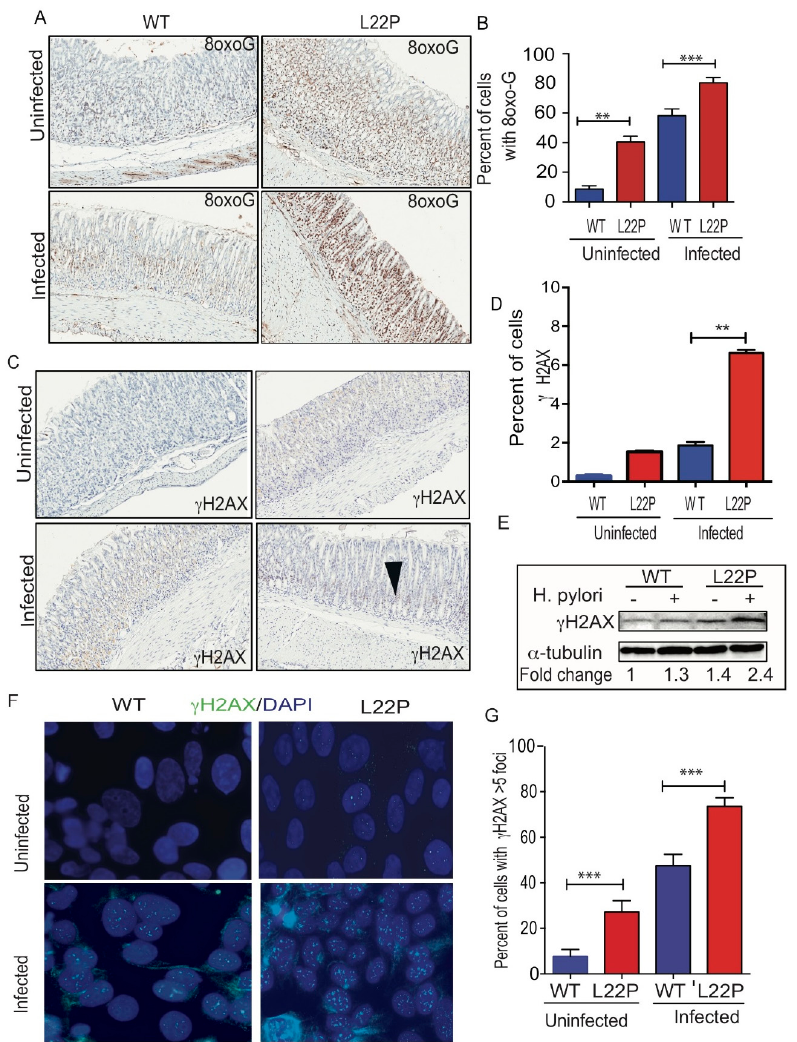
Figure2. Mutationin POLB exacerbates H.pylori inducedgenomicinstabilityinmice. ( A )Representative staining of 8oxoG on WT and L22P cells with and without H. pylori infection; ( B ) Estimated percent of cells positive for 8oxoG lesions on WT and L22P with and without infection; ( C ) Immunohistochemistry staining of γ H2Ax in WT and L22P infected with H. pylori ; ( D ) Estimated percent of positive cells for γ H2AX in WT and L22P infected and non-infected groups; ( E ) Western blot for γ H2AX on WT and L22P mice, with and without infection; ( F ) Localization of γ H2AX in normal human gastric epithelial cells (GES-1) that expressed WT and L22P infected with H. pylori ; ( G ) Estimated percent of cells with γ H2AX positive with and without infected WT and L22P expressing human gastric epithelial cells (GES-1); ( H ) Cell cycle dependent accumulation of double strand breaks in H. pylori infected GES-1cells. Cells were co-cultured and stained with γ H2AX antibody and the cell cycle analysis was performed using flow cytometry; Data analysis was done using Two way ANOVA; ( I ) Representative image of transformed cells after H. pylori infection for 15 days co-culture; and estimated number of foci / field for transformed cells that were infected with H. pylori for 15 days. All statistical analysis was performed using the paired t -test on GraphPad prism software. The statistical significances represented as ** p < 0.01 and *** p <